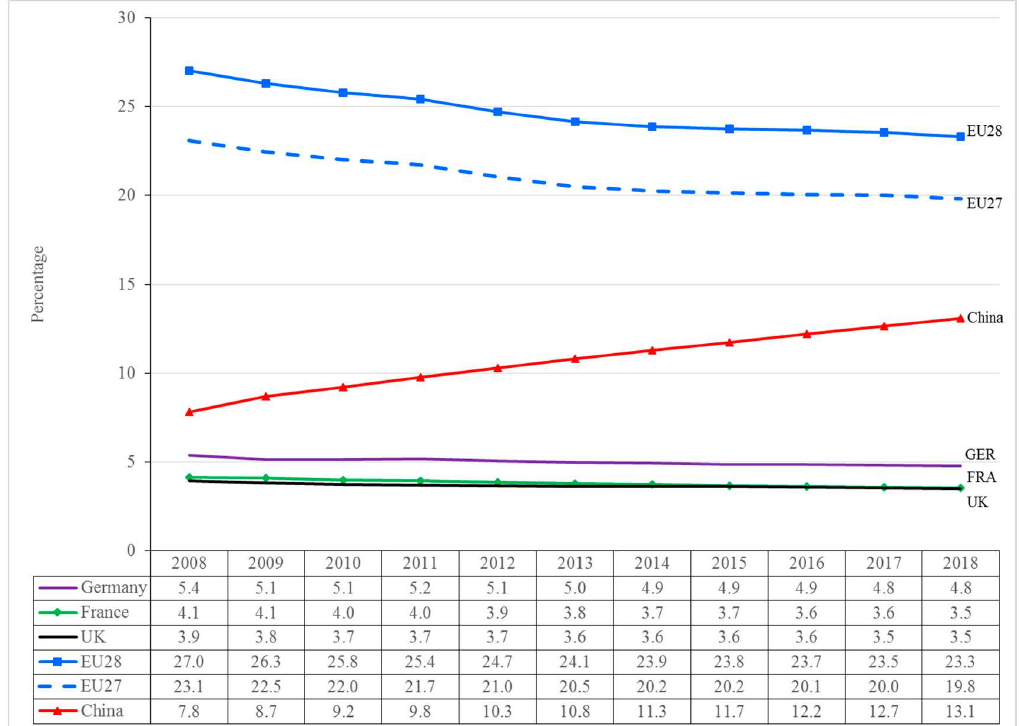
Figure 3 Share of global GDP (%), 2008–18. Source: The World Bank, ‘DataBank’ (2020) <http://databank. worldbank.org/data/home.aspx> accessed 27 February